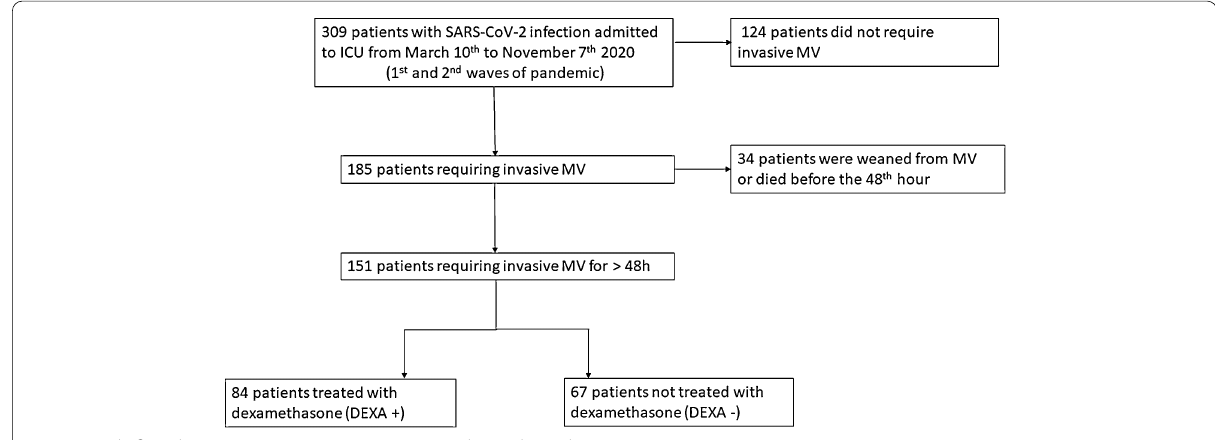
Fig. 1 Study flowchart. ICU intensive care unit, MV mechanical ventilation